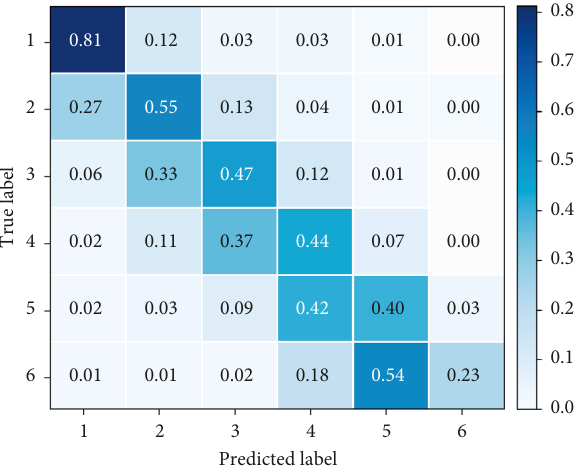
Figure 11: PM2.5 IAQL confusion matrix of MKSVC. Figure 12: PM2.5 IAQL confusion matrix of